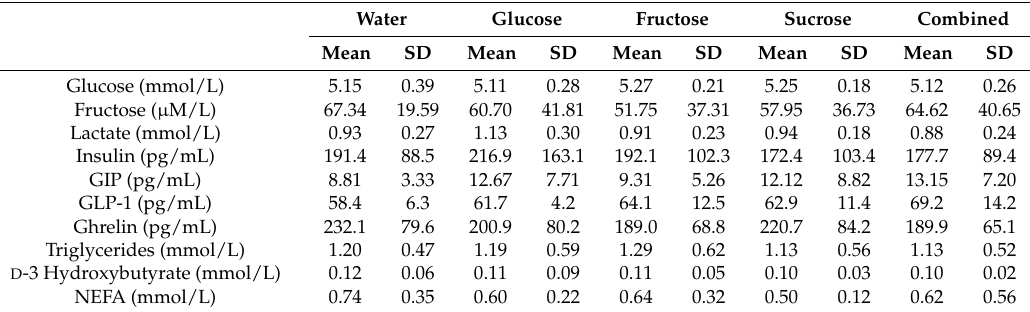
Table 2. Baseline concentrations for blood serum measures.